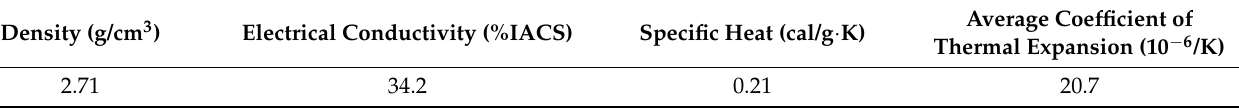
Table 1. Typical physical properties of Duralcan TM